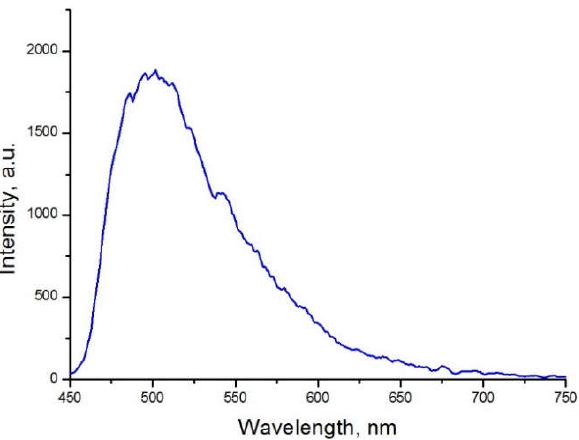
Figure 3. Luminescence spectrum of the films with the Gd(III) complexes at T = 77 K. The experimental phosphorescence spectrum of Gd(III) allowed attainment of the value of the β-diketonate triplet level equal to approximately 20,200 cm −1 . The triplet levels of the ligands and the emission transitions of the lanthanide ions are summarized in the energy level diagram that represents the energy transfer processes occurring in the synthesized complexes. This diagram is shown in Figure 4.